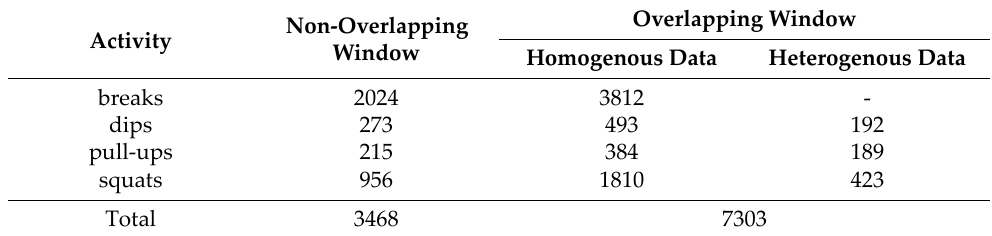
Table 6. The number of input data points used in the training and testing phases for both approaches.